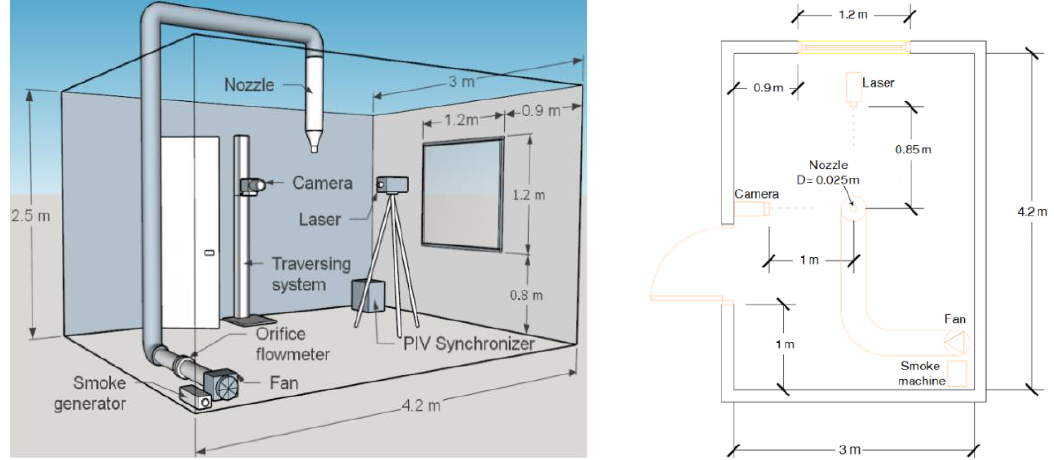
Figure 1. Experimental setup of particle image velocimetry (PIV) measurements.